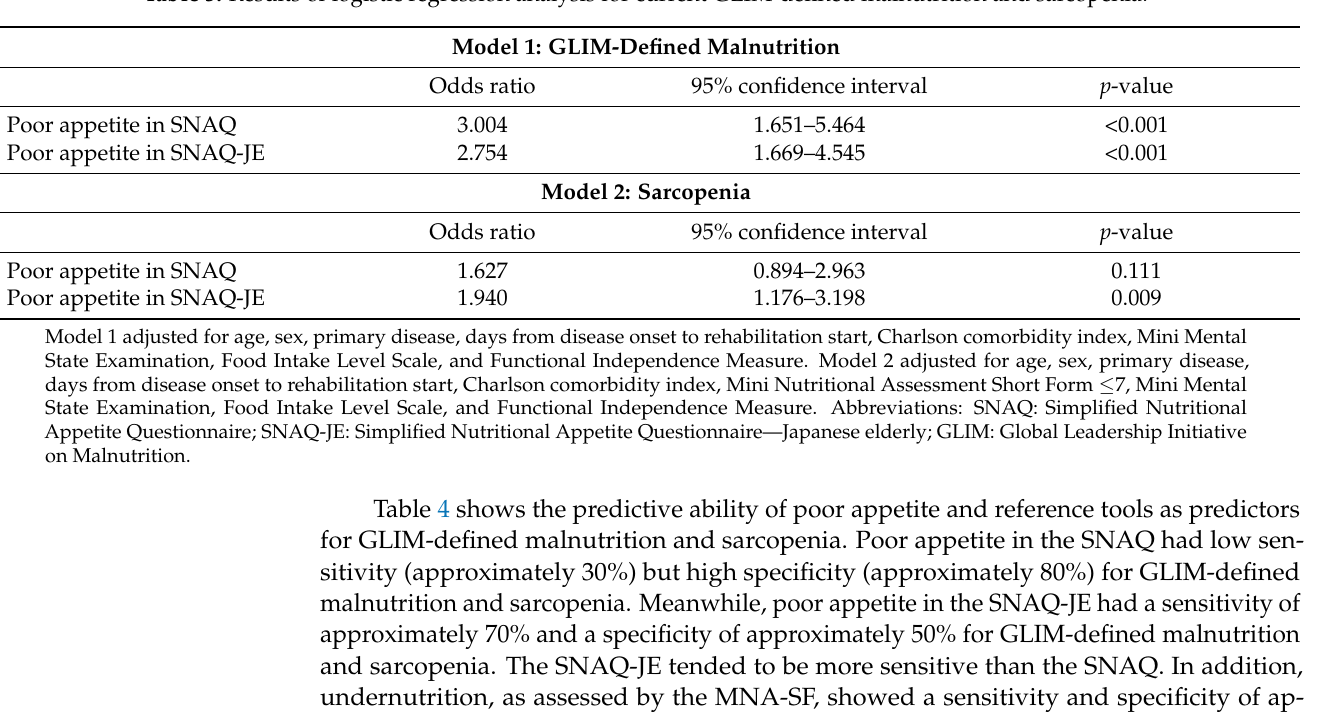
Table 3. Results of logistic regression analysis for current GLIM-defined malnutrition and sarcopenia.